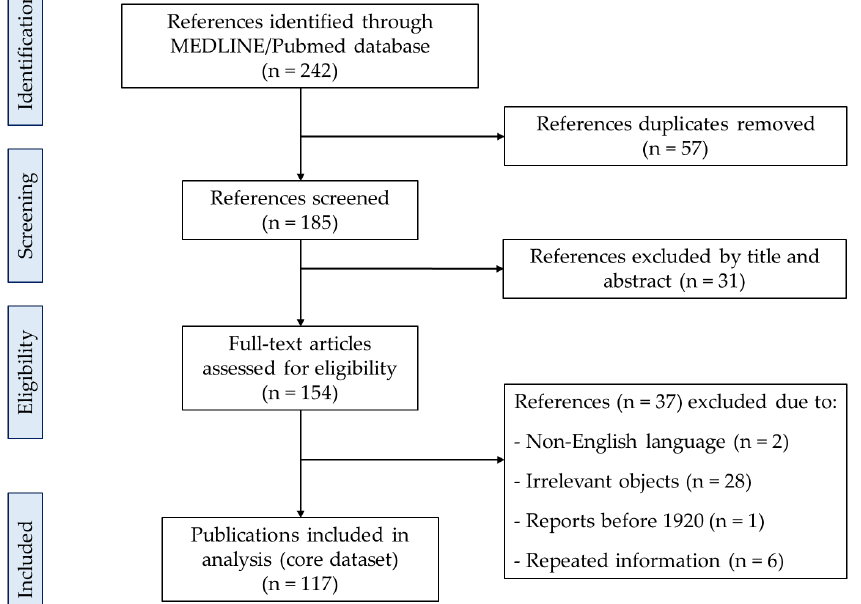
Figure 1. PRISMA flow diagram of references included in the review.